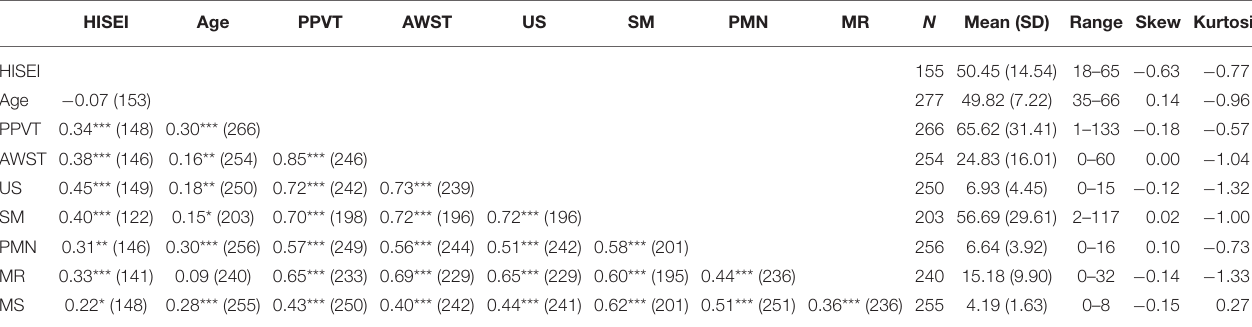
TABLE 2 | Descriptive statistics and bivariate Bonferroni-corrected Pearson correlations ( N ) of children’s characteristics and relevant variables at T1.